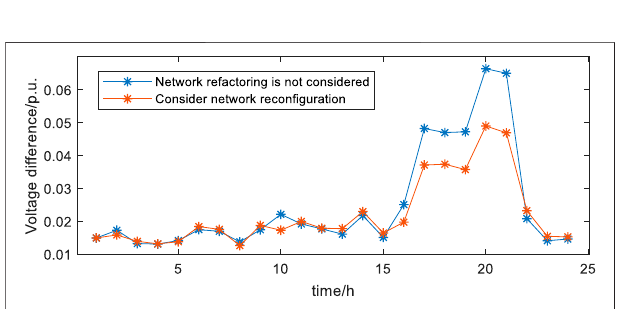
FIGURE 10 | Voltage amplitude deviation at each node of the two